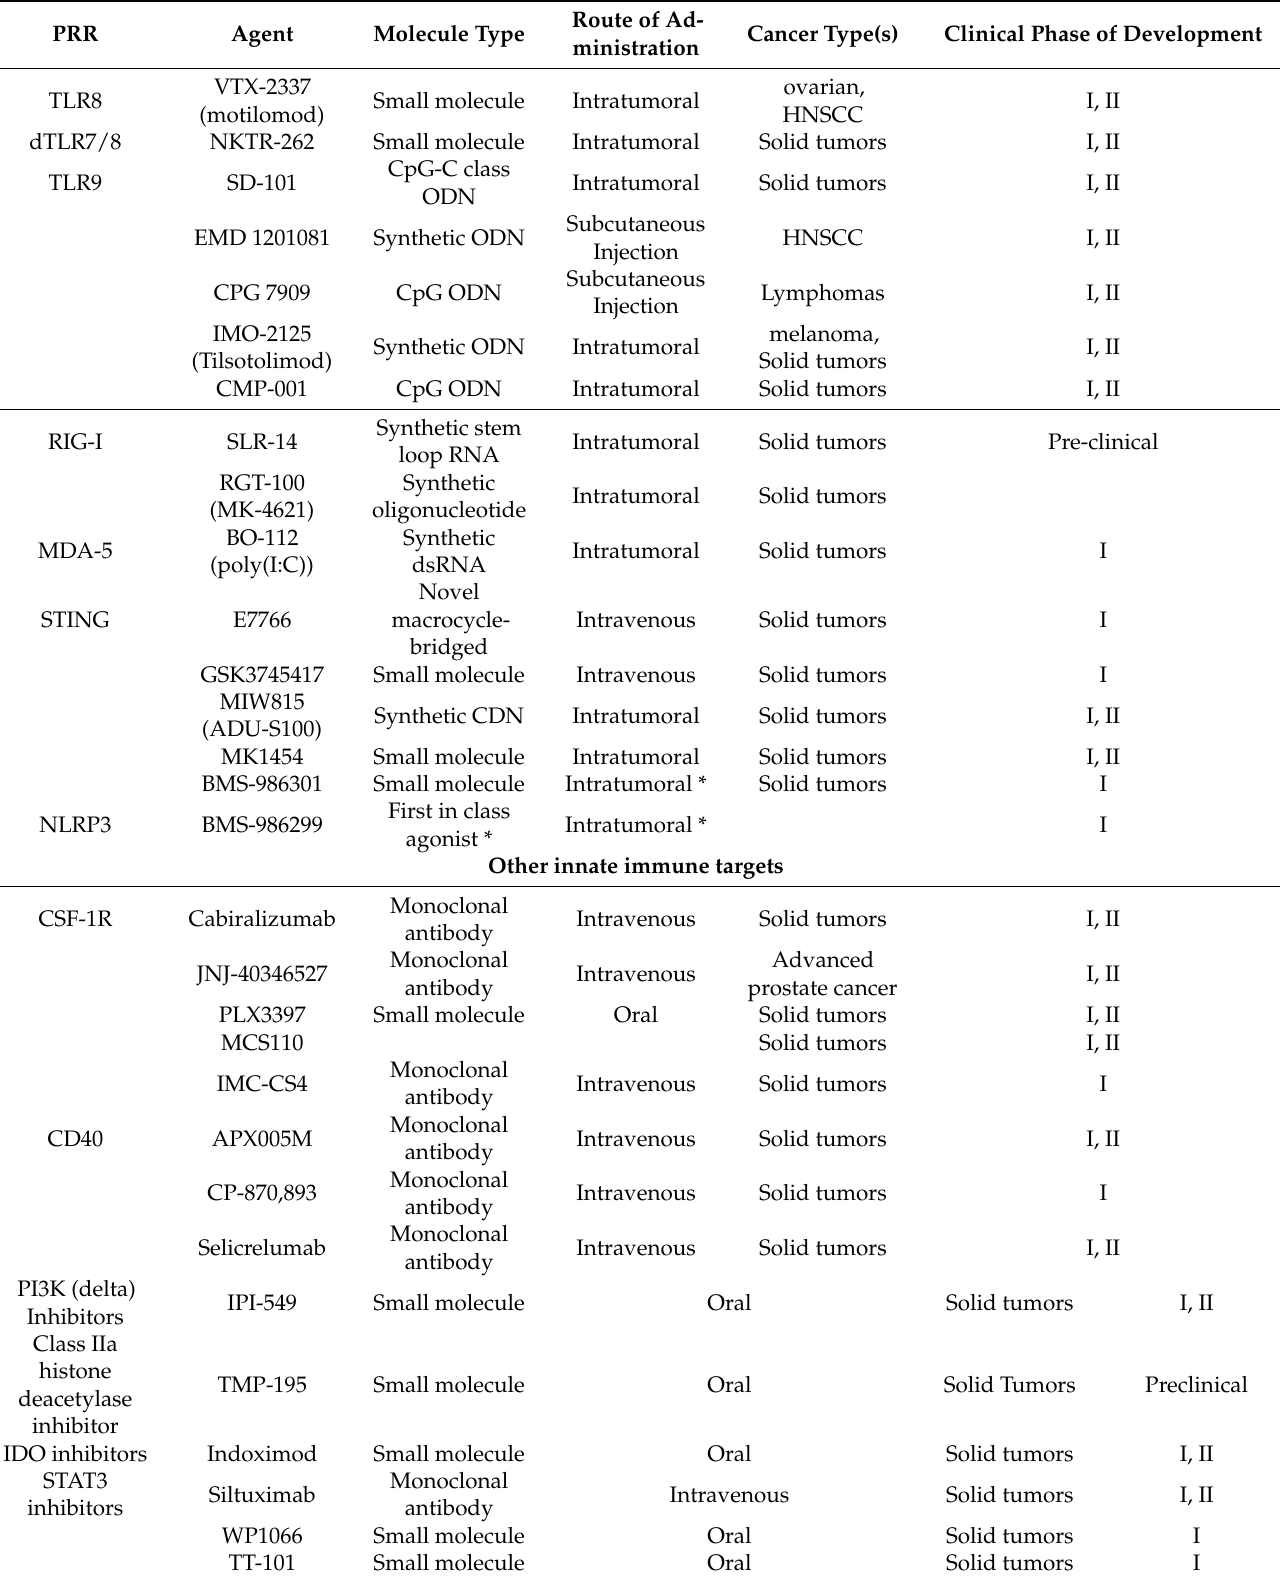
Table 2. Summary of agents in clinical